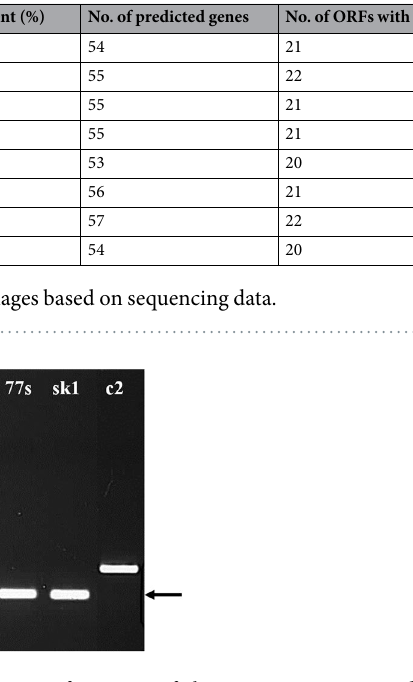
Figure 4. Phage typing using multiplex PCR. Unique fragments of phage genomes were amplified using a mix of primers complementary to the conserved genomic regions of 936- and c2-type phages. Arrows indicate the